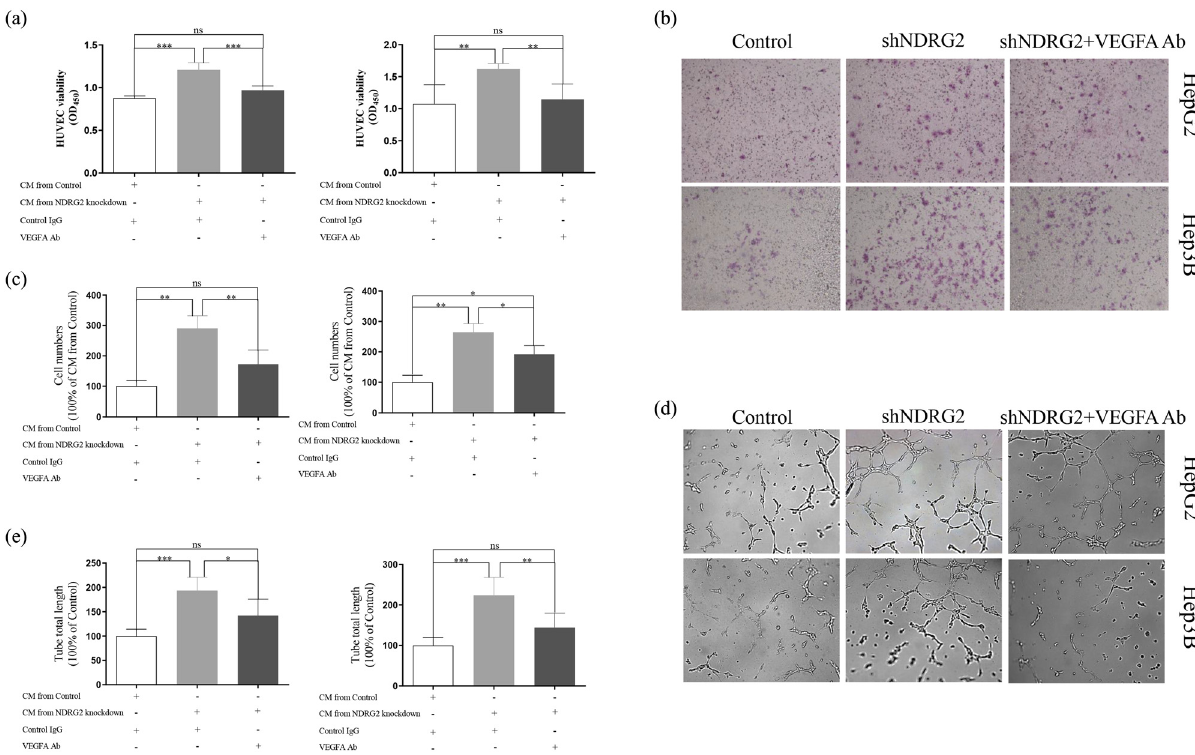
Figure 3: VEGFA may be involved in the NDRG2 - knockdown promoting angiogenesis in HepG2 and Hep3B cells. VEGFA antibody was added to the CM. CM from NDRG2 knockdown cells with VEGFA antibody failed to induce HUVECs proliferation ( a ) , migration ( b and c ) , and tube formation ( d and e ) . ns, no signi fi cance; * P < 0.05; ** P < 0.01; *** P < 0.001.